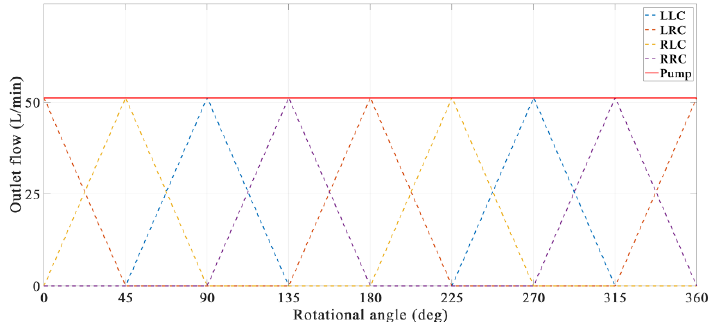
Figure 2. The theoretical outlet flow of the parallel 2D piston pump.